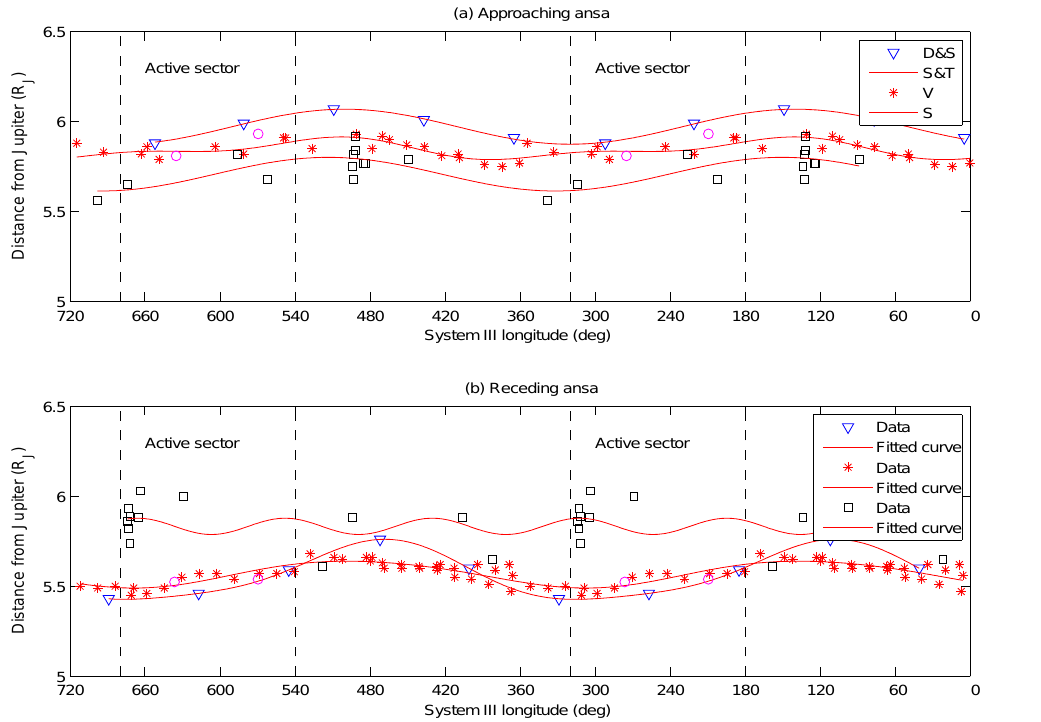
Figure 3. The distance of the approaching (a) and receding (b) ansa as a function of system III longitude from different studies: Dessler and Sandel (1992) in blue triangles, Schneider and Trauger (1995) in red asterisks, Smyth et al. (2011) in magenta circles and this study in black squares. The red lines are second-order Fourier fits to the